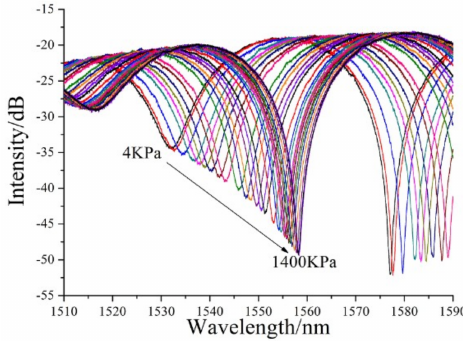
Figure 6. FP interference spectrum of the microbubbles.